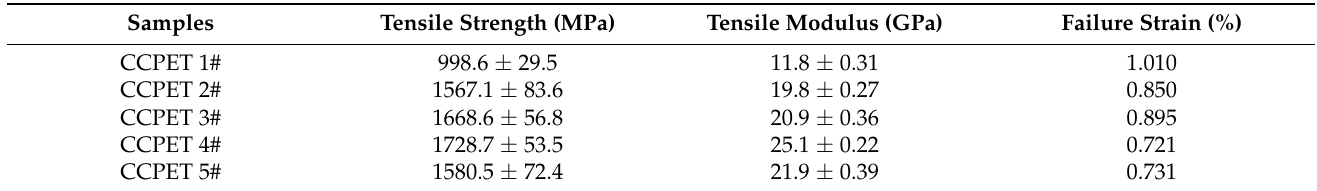
Figure 4. Representative tensile stress–strain curves of tensile specimens of CNT/CCF/PET composites with different fiber content and CNT content. Table 3. Tensile properties of CNT/CCF/PET composites with different fiber content and CNT